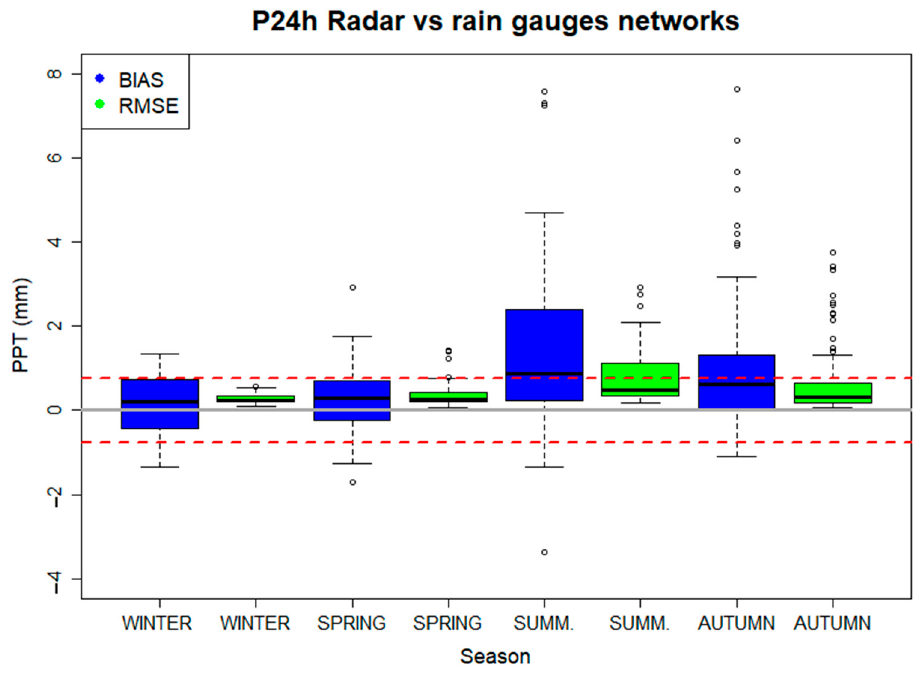
Figure 5. Seasonal distribution of the calculated 24 h rainfall BIAS and RMSE between XRAD products and the BCASA rain gauge network for the 207 rainfall episodes in the ROI.